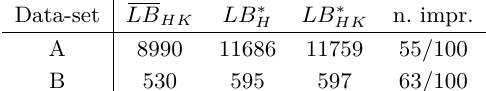
Table 1 Comparison between optimized and non-optimized 1-tree-based lower